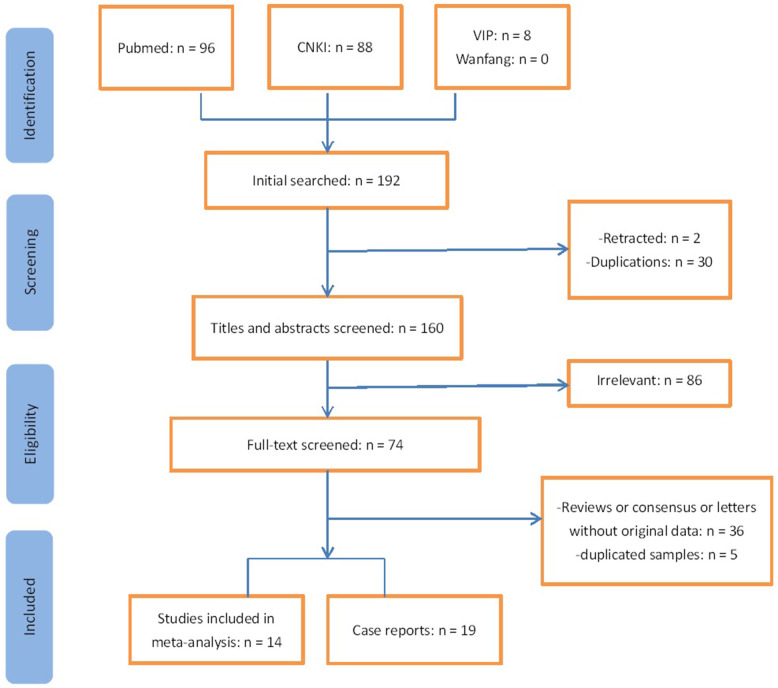
Flow chart of study selection.